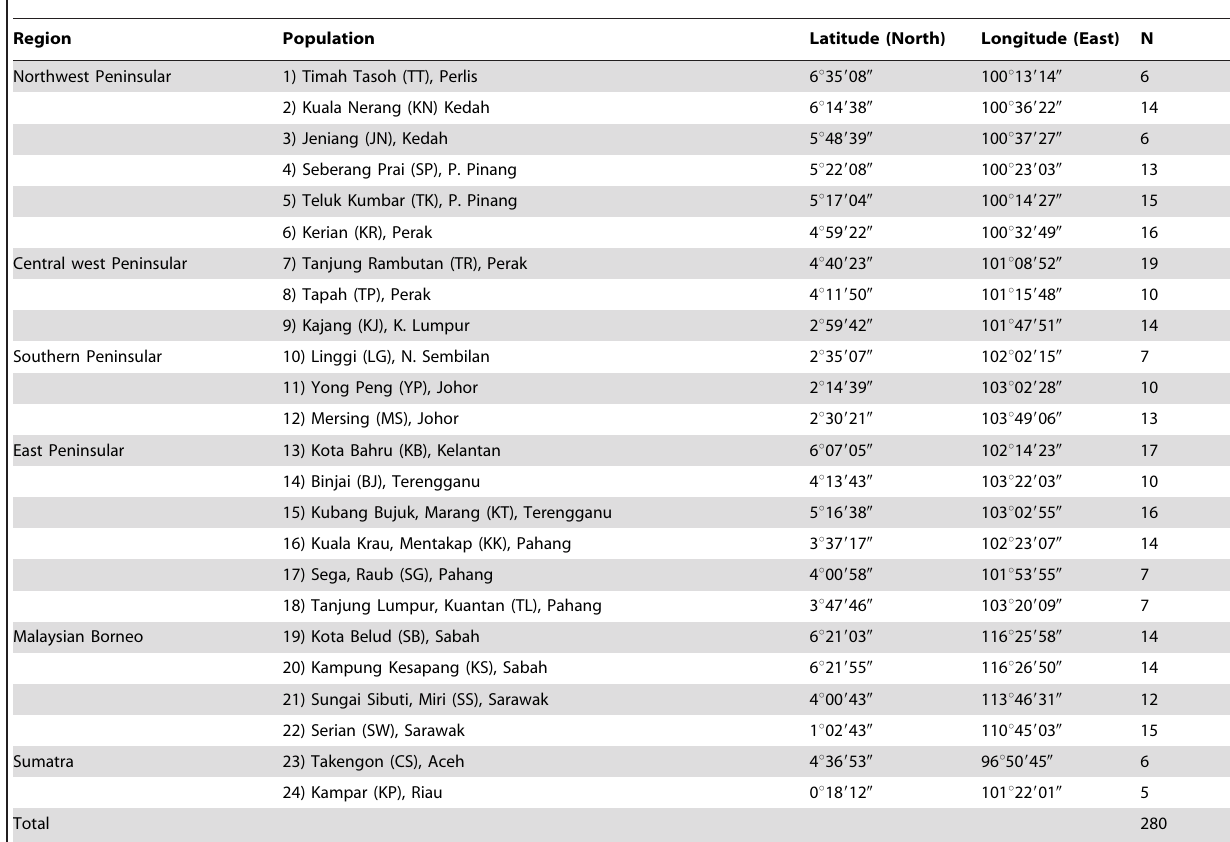
Table 1. Geographical coordinates of 24 sampled locations.